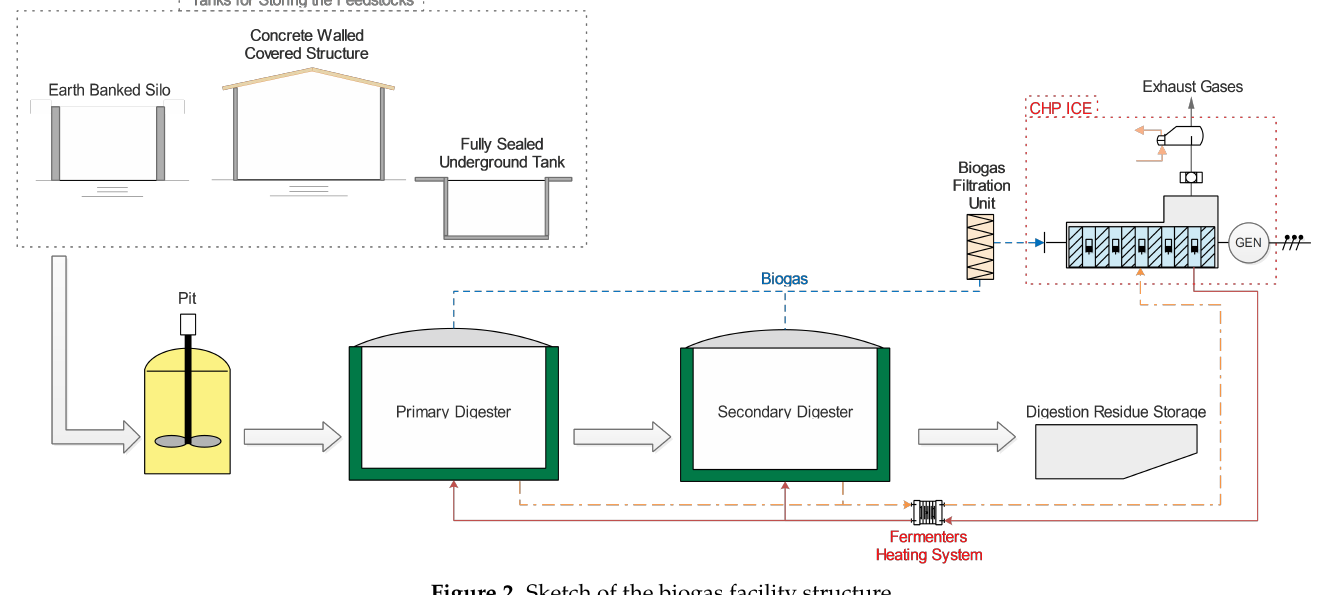
Figure 2. Sketch of the biogas facility